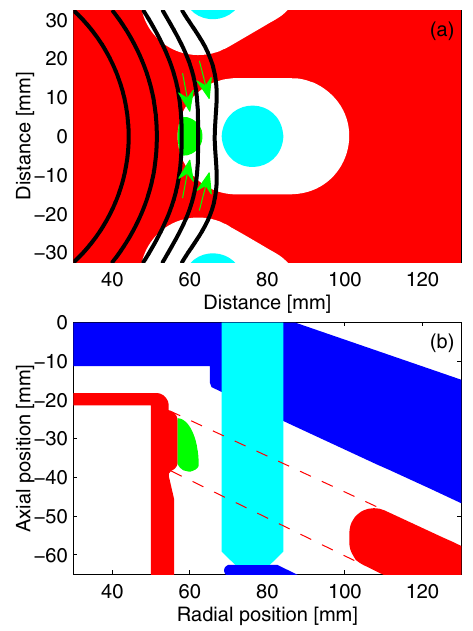
FIG. 2. (a) An R − θ cross section of the upper post-hole convolute. Magnetic field lines are shown in black. Cartoon representations of plasma formation and the collection sites [22] on the downstream side of the convolute are shown in green. (b) An R − Z cross section of the convolute showing the plasma collection site as predicted in simulations